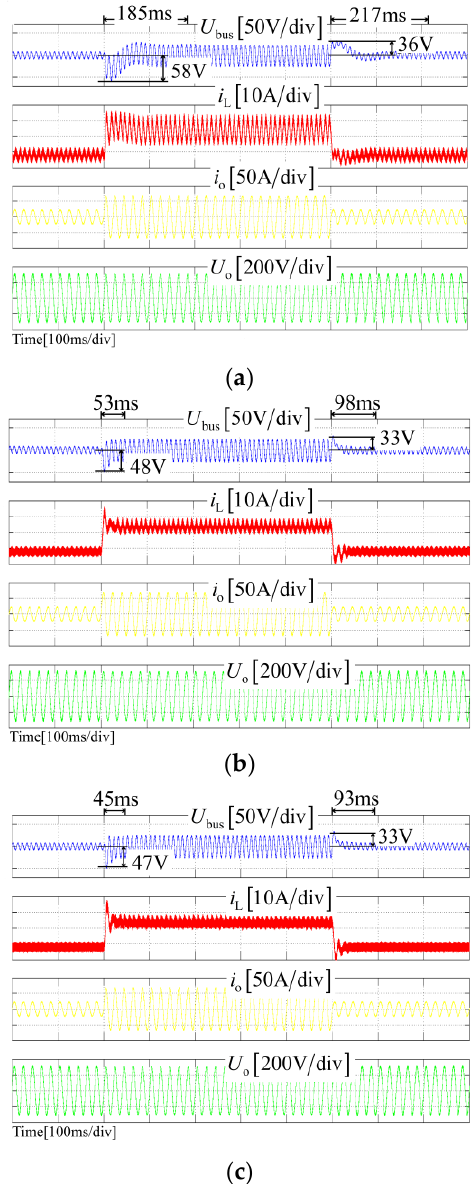
Figure 13. Dynamic simulation results between 33% and 100% full load. ( a ) Scheme I; ( b ) scheme II; ( c ) proposed NICFPS.